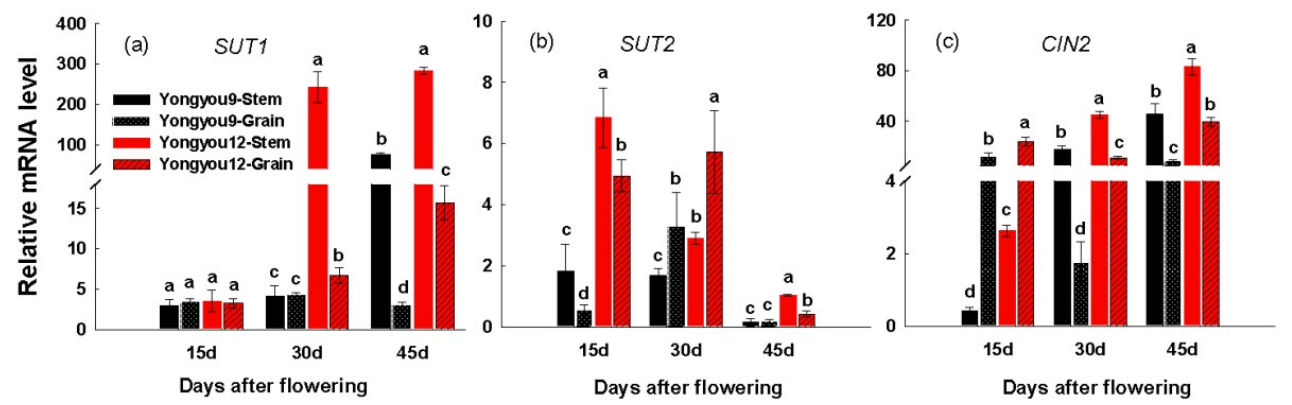
Figure 9. Gene expression of SUT1 ( a ), SUT2 ( b ), and CIN2 ( c ) in stems and grain after rice flowering. Error bars denote ± standard deviation ( n = 3). Different letters indicate a significant difference within the same measurement period at the 0.05 probability level.